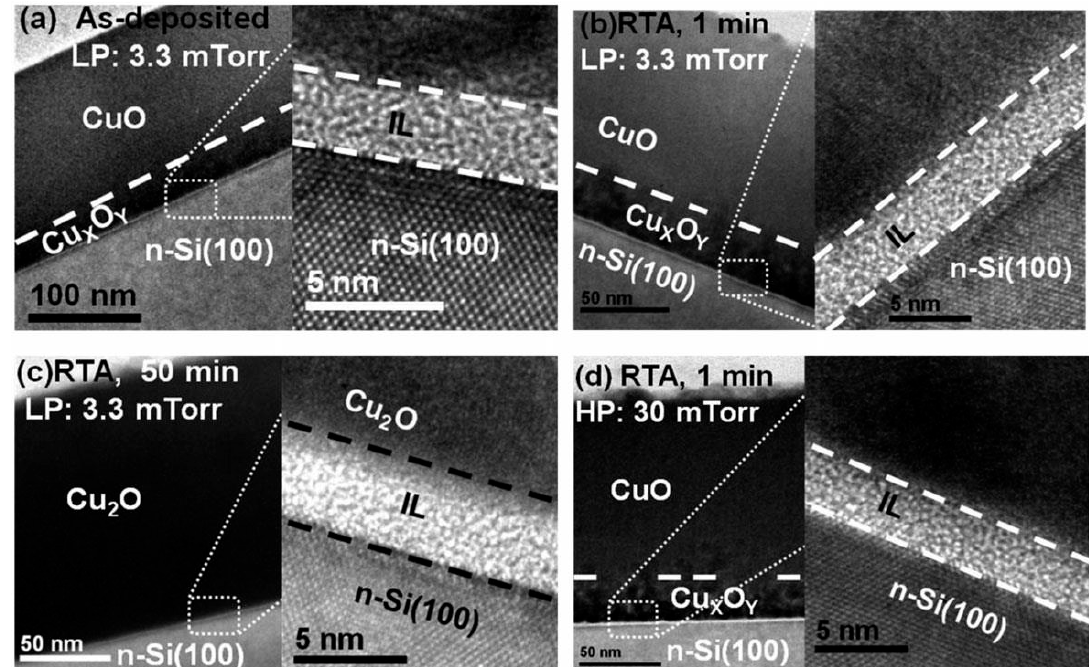
Figure 8. Cross sectional TEM image of 150 nm thick CuO films deposited on n-type Si(100) substrates at a working pressure of 3.3 mTorr: ( a ) as-deposited; ( b ) annealed at 300 °C for 1 min; and ( c ) annealed at 300 °C for 50 min. The same thickness CuO film deposited at a working pressure of 30 mTorr and annealed for 1 min at 300 °C is shown in ( d ) © 2014 John Wiley & Sons, Ltd. [41].